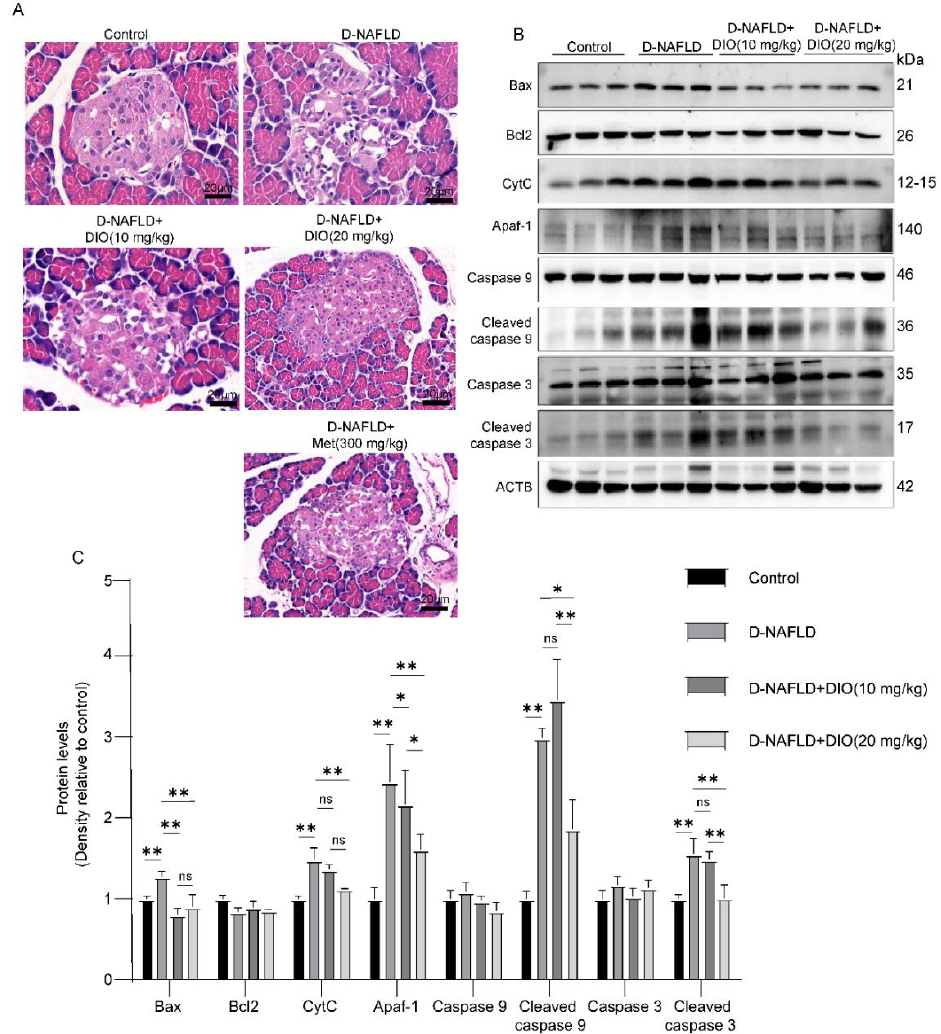
Figure 2. DIO relieved pancreatic injury and mitochondrial apoptosis in D-NAFLD rats. ( A ) H&E staining of pancreas, × 200. ( B ) Western blot images of Bax, Bcl2, CytC, Apaf-1, caspase 9, and caspase 3 in pancreas. ( C ) Relative protein expressions of Bax, Bcl2, CytC, Apaf-1, caspase 9, cleaved caspase 9, caspase 3, and cleaved caspase 3 in pancreas. n = 3 and the data were presented as mean ± SD. ns indicates no significance, * and ** indicate significant difference and highly significant difference, respectively.